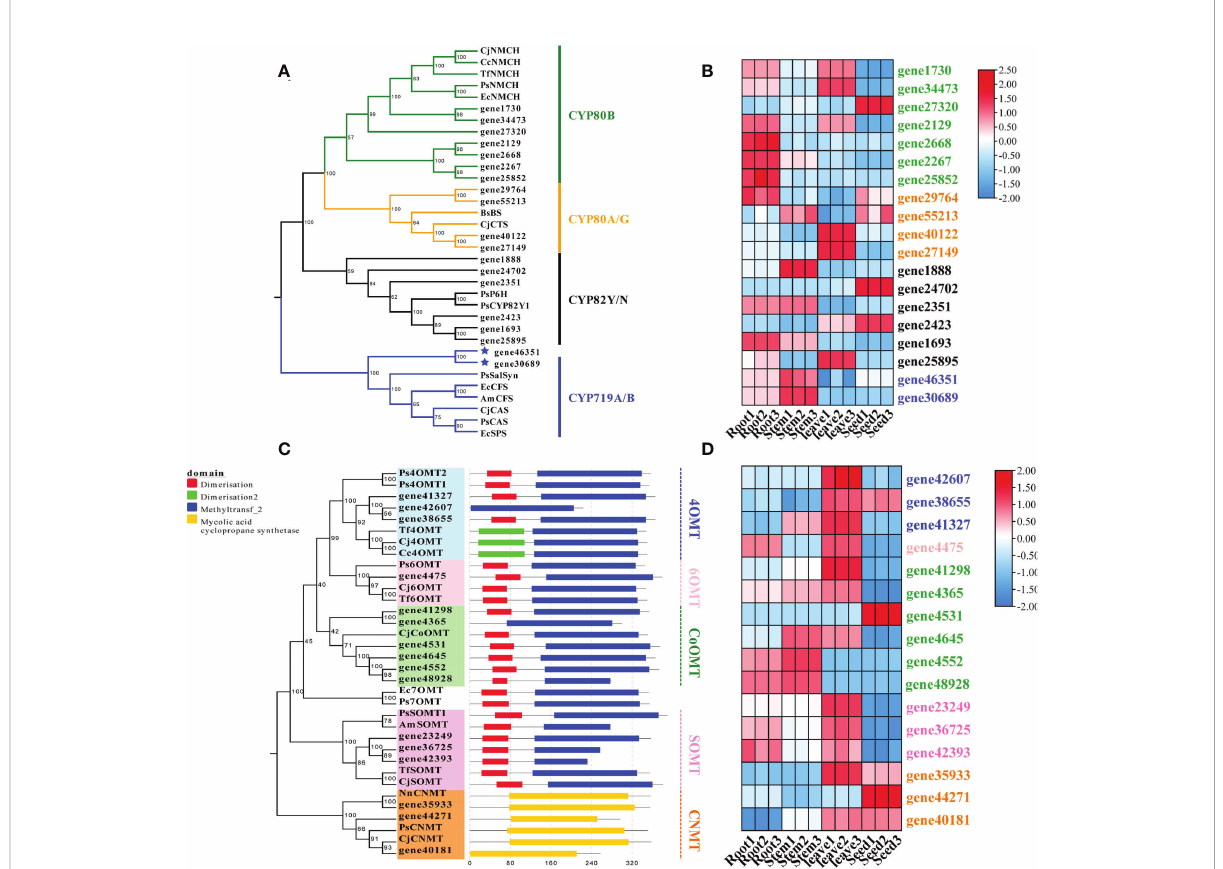
FIGURE 6 Phylogenetic analysis and expression patterns of CYPs and methyltransferases in S. acutum . (A) Phylogenetic tree of the candidate CYPs with known CYPs involved in BIA biosynthesis. (B) Expression levels of the screened CYP-encoding genes in the root, stem, leaf, and seed of S. acutum. (C) Phylogenetic tree of the candidate methyltransferases for BIA biosynthesis. (D) Expression levels of genes encoding the methyltransferases for BIA biosynthesis in the root, stem, leaf, and seed of S. acutum.